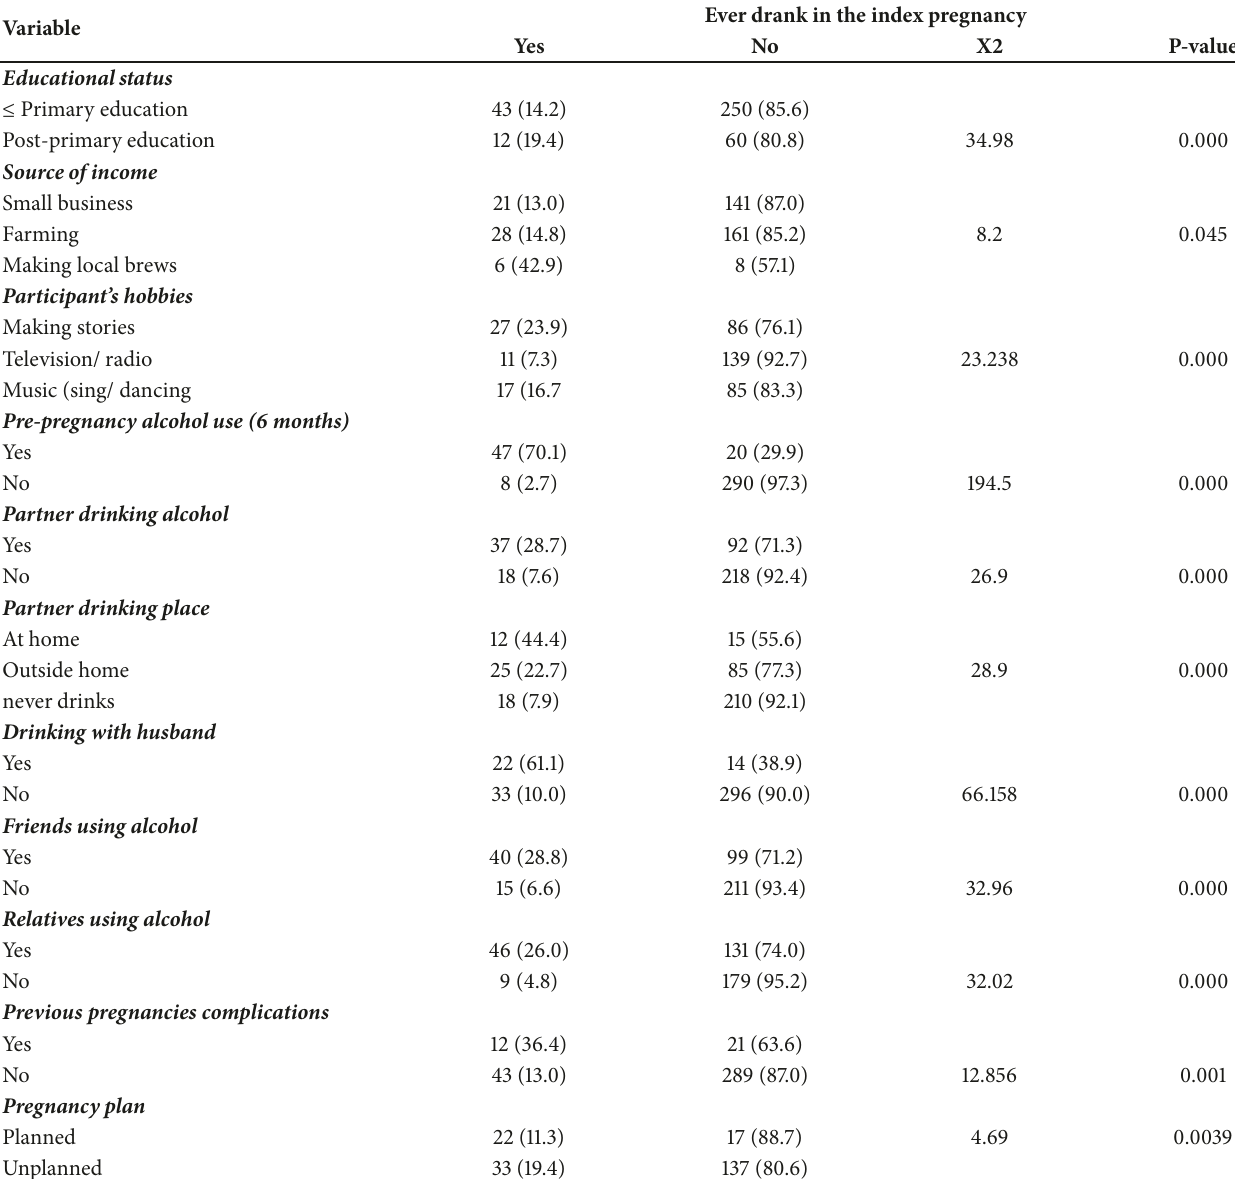
Table 3: Factors associated with alcohol use among pregnant women attending Reproductive and Child Health (RCH) clinic in Dodoma using chi-square